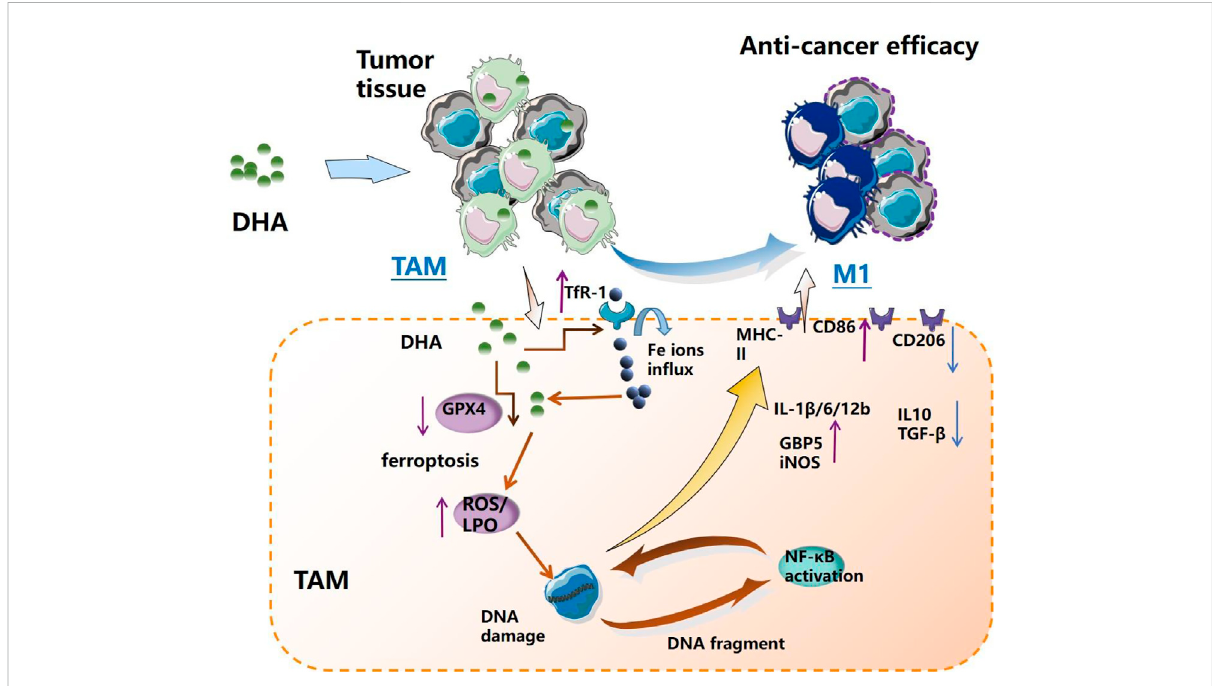
FIGURE 10 Schematic diagram of the mechanism of DHA-mediated reprogramming of TAM through ferroptosis. DHA-triggered ferroptosis of TAM generates ROS/LPO, leading to DNA damage, which activates downstream NF- κ B to remodel TAM to the M1 phenotype. The reprogrammed macrophages possess an anti-tumor